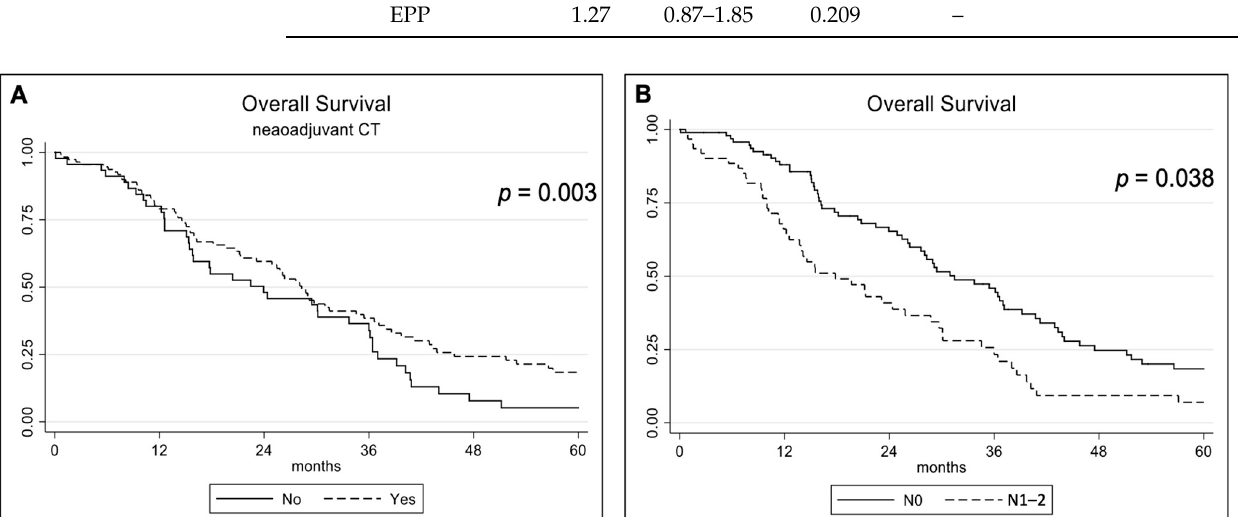
Figure 2. Overall survival curves according to the execution of induction therapy ( A ) and pathological node involvement (pN0 vs. pN+) ( B ).